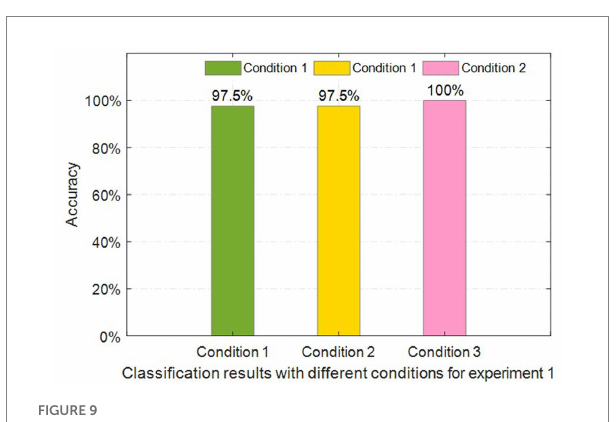
FIGURE 9 Classification accuracies under three conditions for the first